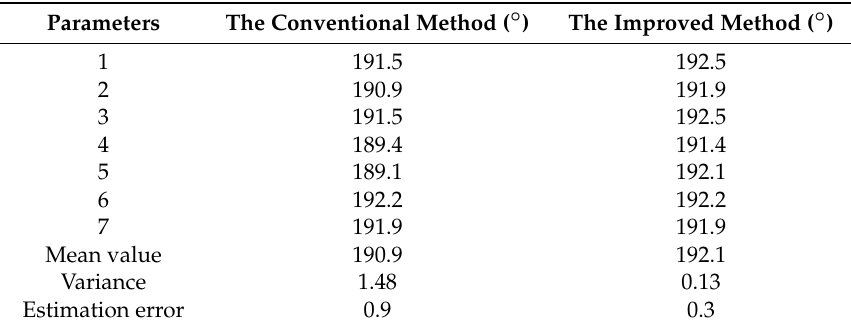
Table 3. Analysis of the target azimuth angle estimation result.